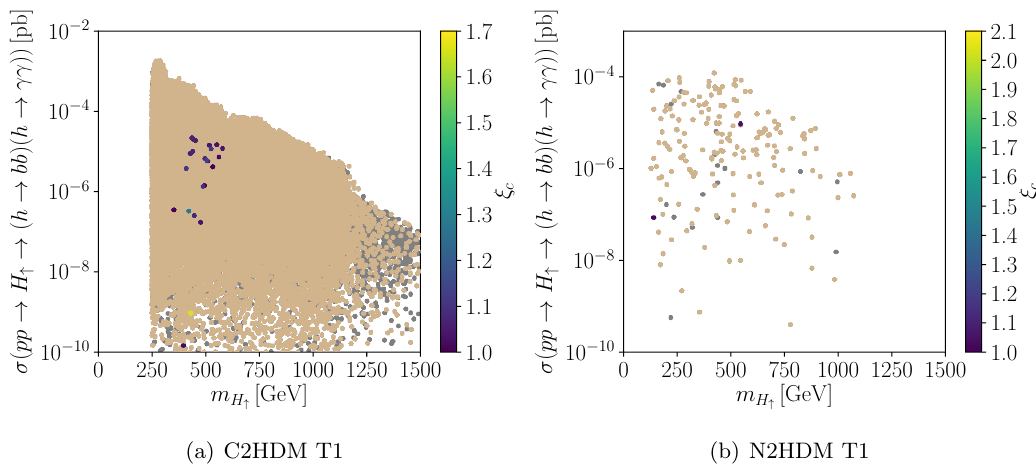
Figure 15 . T1: production rate of H " with subsequent decay into hh in the (2 b )(2 (cid:13) ) (cid:12)nal state versus m H for the C2HDM (left) and the N2HDM (right). The color code is the same as in " (cid:12)gure 3. The color bar indicates the strength of the phase transition for (cid:24) c search constraints are